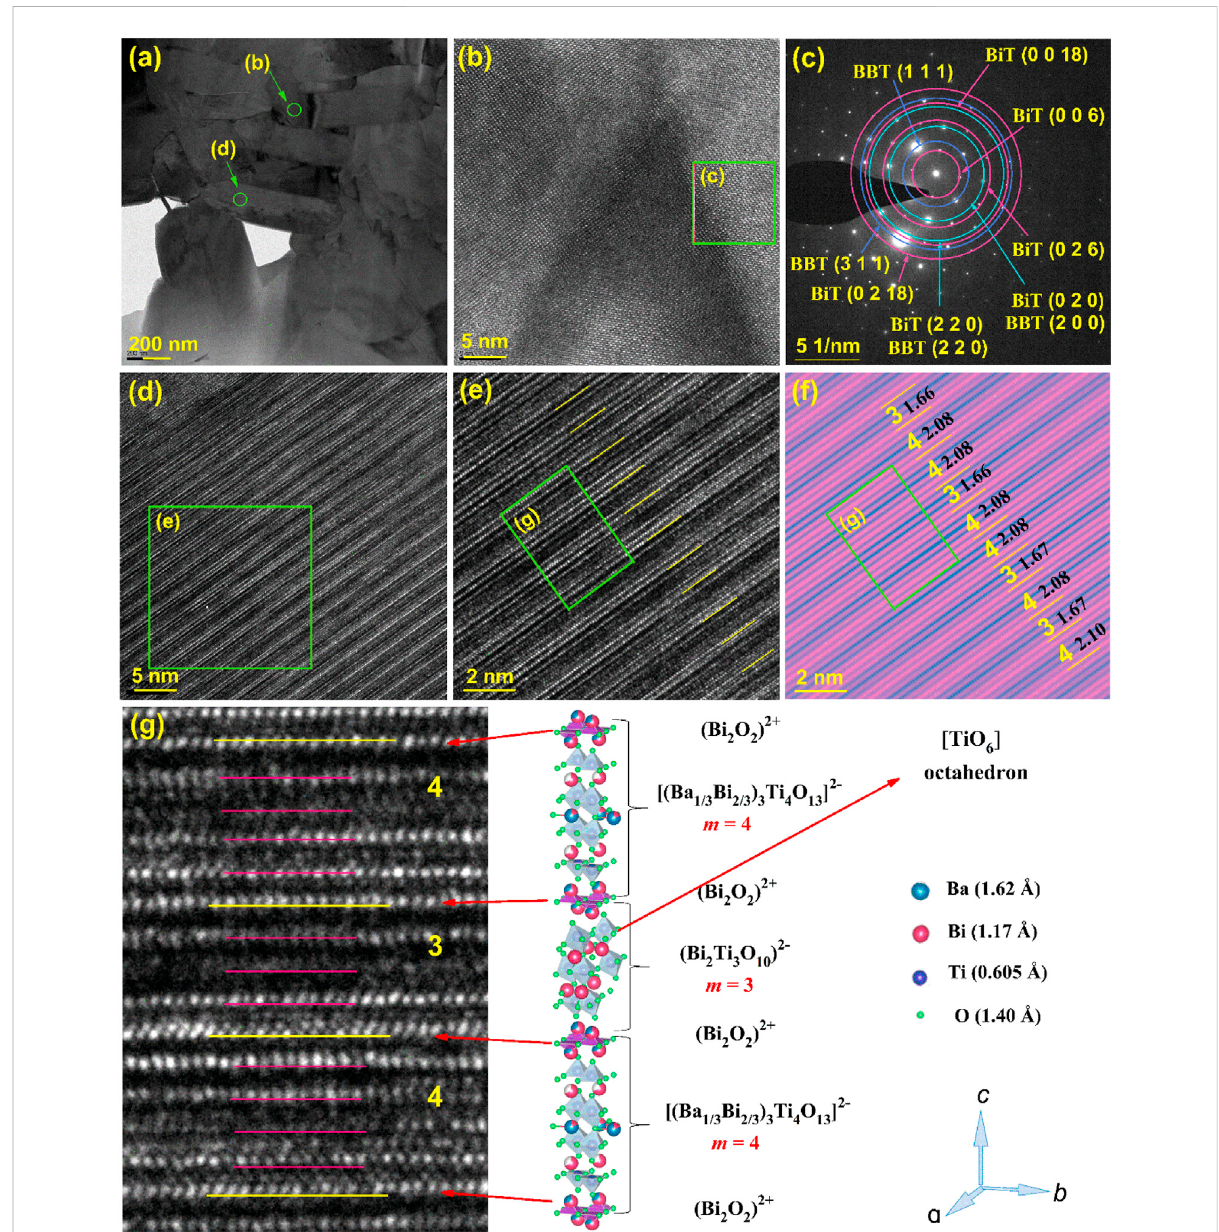
FIGURE 4 TEM images and schematic crystal structure of the 0.8BBT-0.2BiT ceramics: (A) Cross-sectional TEM image, (B) high-resolution Cross- sectional TEM image, (C) FFT image of Figure 4 (B,D) high-resolution Cross-sectional TEM image, (E) a partial larger version of Figure 4 (D,F) high contrast view with layer spacing of Figure 4 (E,G) a partial larger version of Figure 4 (E) with its schematic crystal